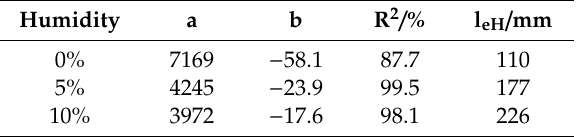
Table 6. Parameters for the relationship between the maximum shear stress and temperature. T ◦ C A 3 A 4 p l 0 R 2 / % l eT / mm 20 8431 0 3 41.8 99.8 110 25 7542 12 3 42.5 96.2 363 30 6024 10 3 40.2 97.5 409 40 3421 5 3 50.2 98.5 563 Table 7. Parameters for the relationship between the maximum shear stress and humidity. Humidity a b R 2 / % l eH / mm 0% 7169 − 58.1 87.7 110 5% 4245 − 23.9 99.5 177 10% 3972 − 17.6 98.1